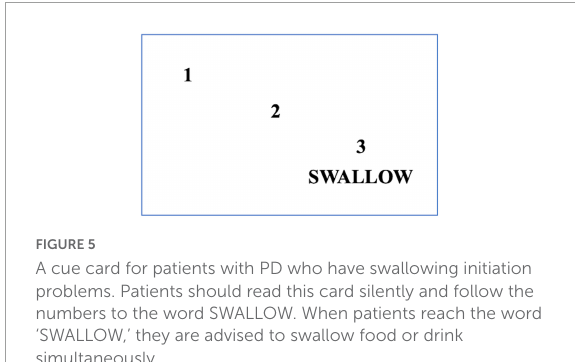
FIGURE5 A cue card for patients with PD who have swallowing initiation problems. Patients should read this card silently and follow the numbers to the word SWALLOW. When patients reach the word ‘SWALLOW,’ they are advised to swallow food or drink simultaneously.